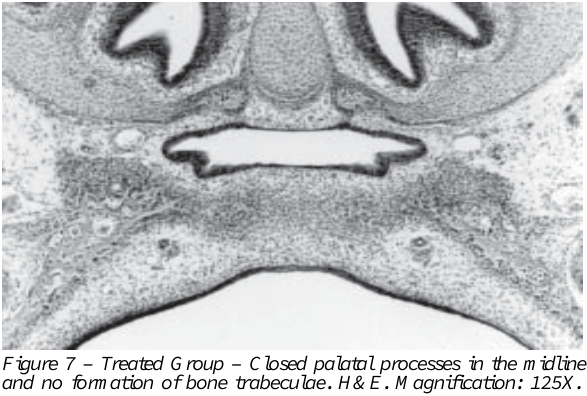
Figure 7 – Treated Group – Closed palatal processes in the midline and no formation of bone trabeculae. H&E. Magnification: